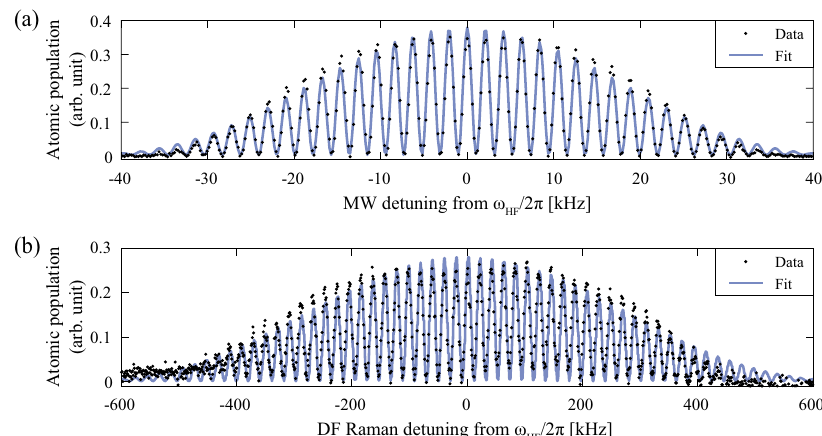
! T ! π Fig. 7 Ramsey interferometry ( π ) of sub-Doppler cooled GMOT atoms at the compact LPAI sensor head. a The atomic fringe of Ramsey 2 2 interferometry versus microwave detuning from atomic resonance ( ω HF /2 π ). The interrogation time T is 450 μ s, resulting in a fringe spacing of δω Ramsey / 2 π ≃ 2.27 kHz. The measurement data rate is 13.33 Hz. b The atomic fringe of Ramsey interferometry versus Doppler-free Raman detuning from atomic resonance ( ω HF /2 π ). The interrogation time T is 48.08 μ s, resulting in a fringe spacing of δω Ramsey /2 π ≃ 19.74 kHz. The measurement data rate is 10 Hz. Both plots are based on a single shot-to-shot